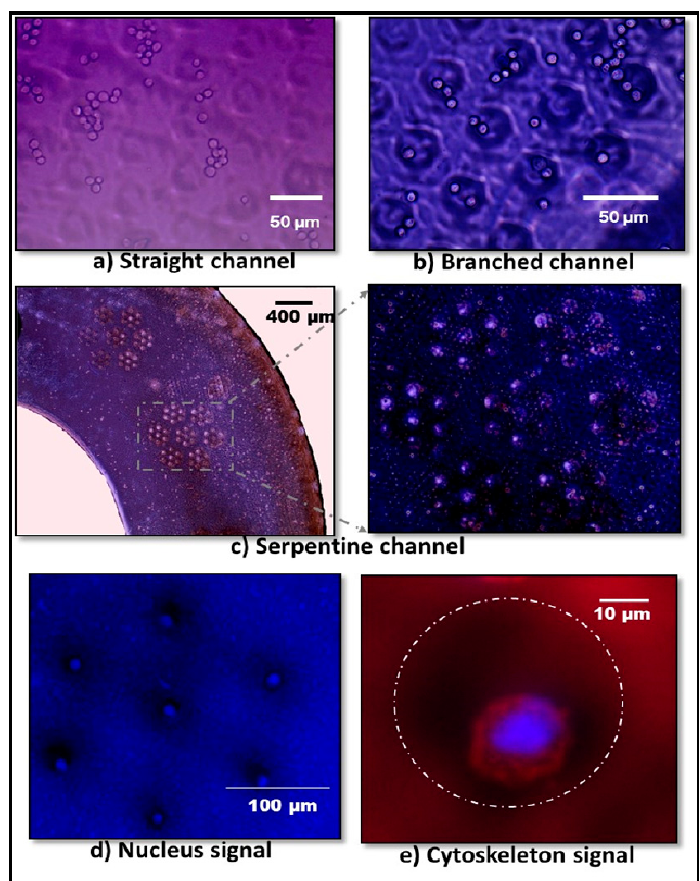
channel, branched channel, and serpent channel, respectively; ( d ) the fluorescence signal from the nucleus (DAPI) of single cells being captured in the serpent channel; and ( e ) single-cell cytoskeleton (fluorescence image) after 3 h of incubation from loading to the serpent channel biochip, showing the blue signal from the nucleus (DAPI) and red from the actin (Rhodamine Phalloidin).